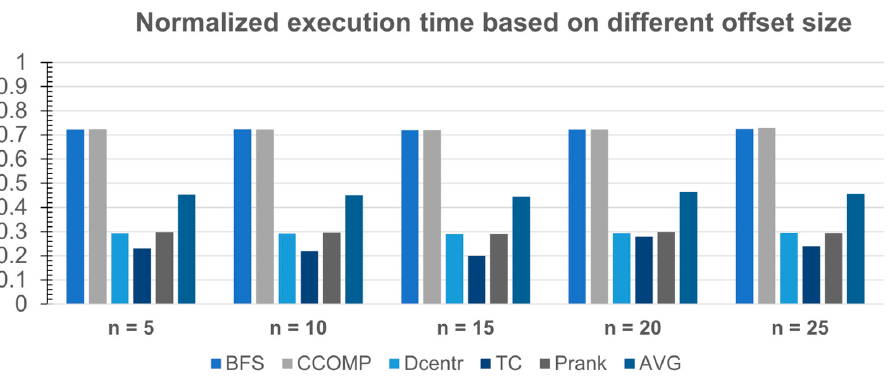
Figure 9. Execution time for different offset sizes.